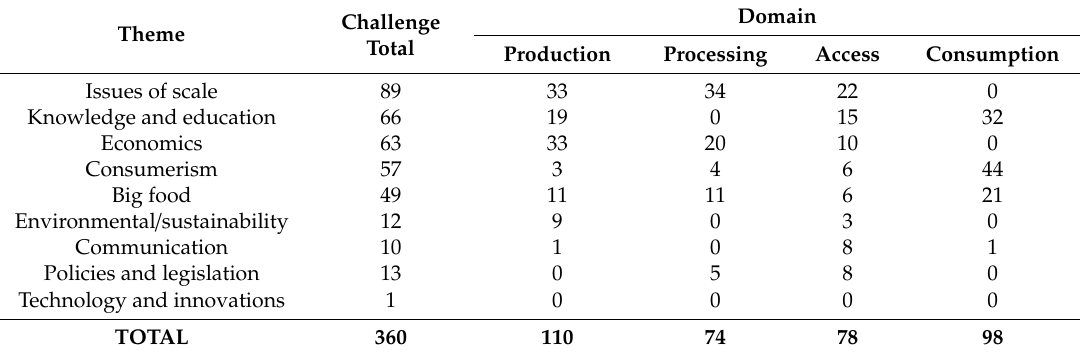
Table 2. Challenges associated with transitioning towards a sustainable food system, across domains and themes determined by participants.